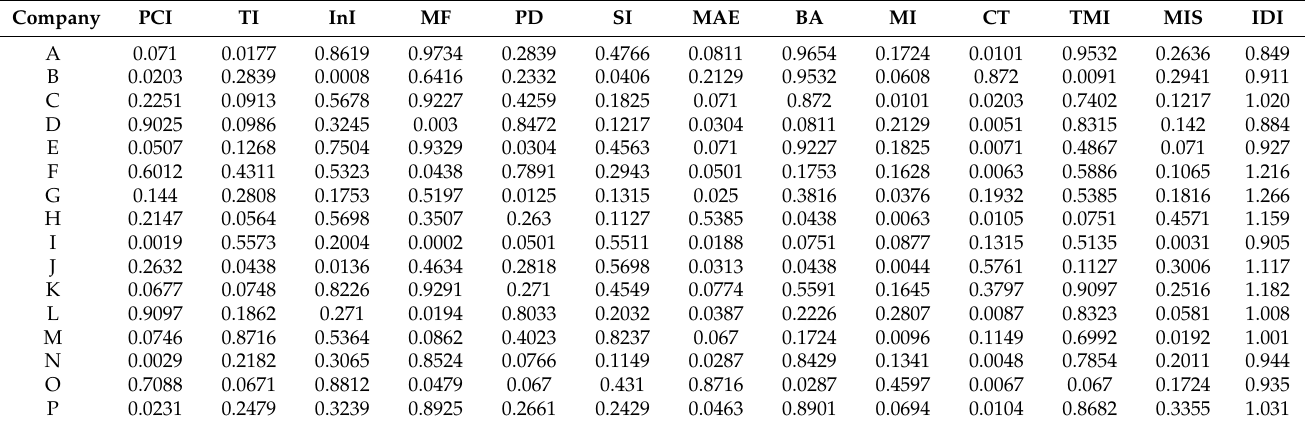
Table 3. Initial data for calculating the integrated development level of the studied